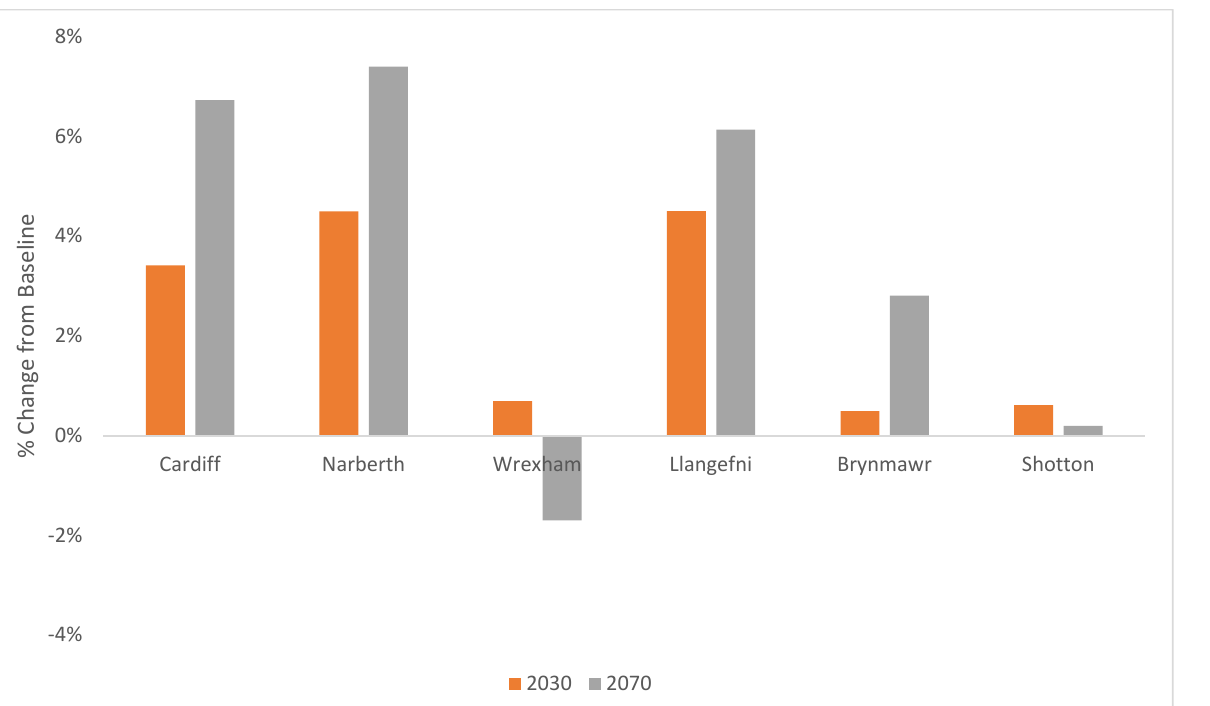
Figure 9. Average annual precipitation for six locations throughout Wales for baseline, 2030 and 2070.